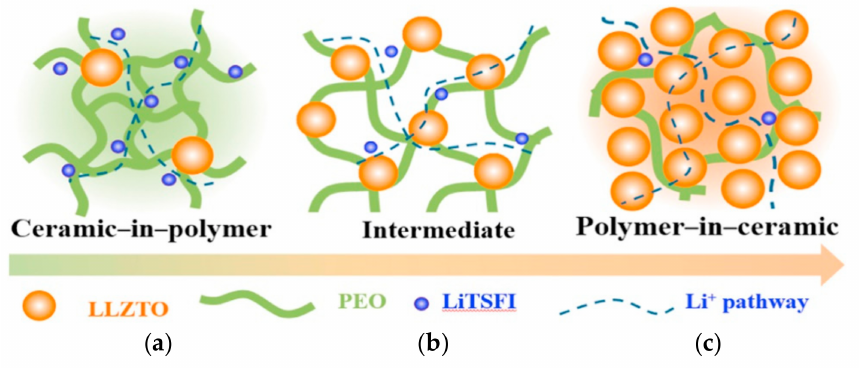
Figure 6. Schematic illustration for PEO–LLZTO ceramic/polymer solid electrolyte: ( a ) ceramic-in-polymer; ( b ) intermediate; ( c ) polymer-in-ceramic